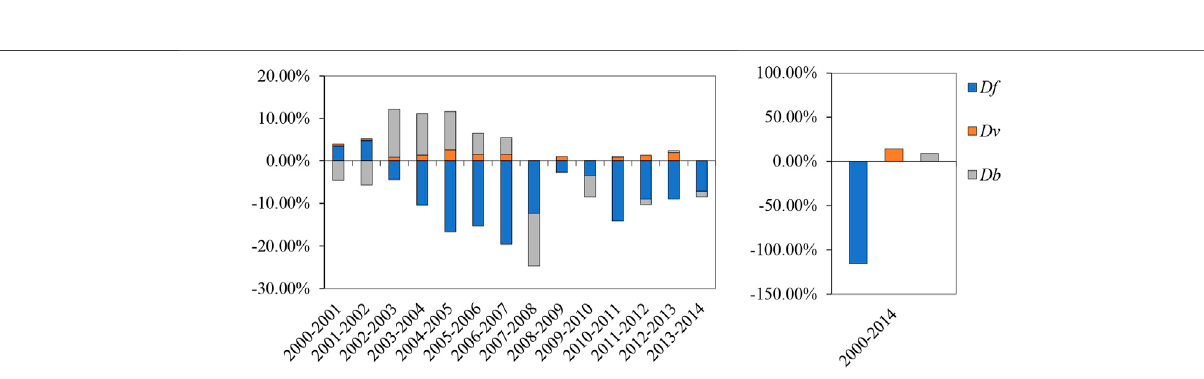
FIGURE 4 | DCEI of the world ’ s major construction countries in the years 2000, 2008, and 2014.